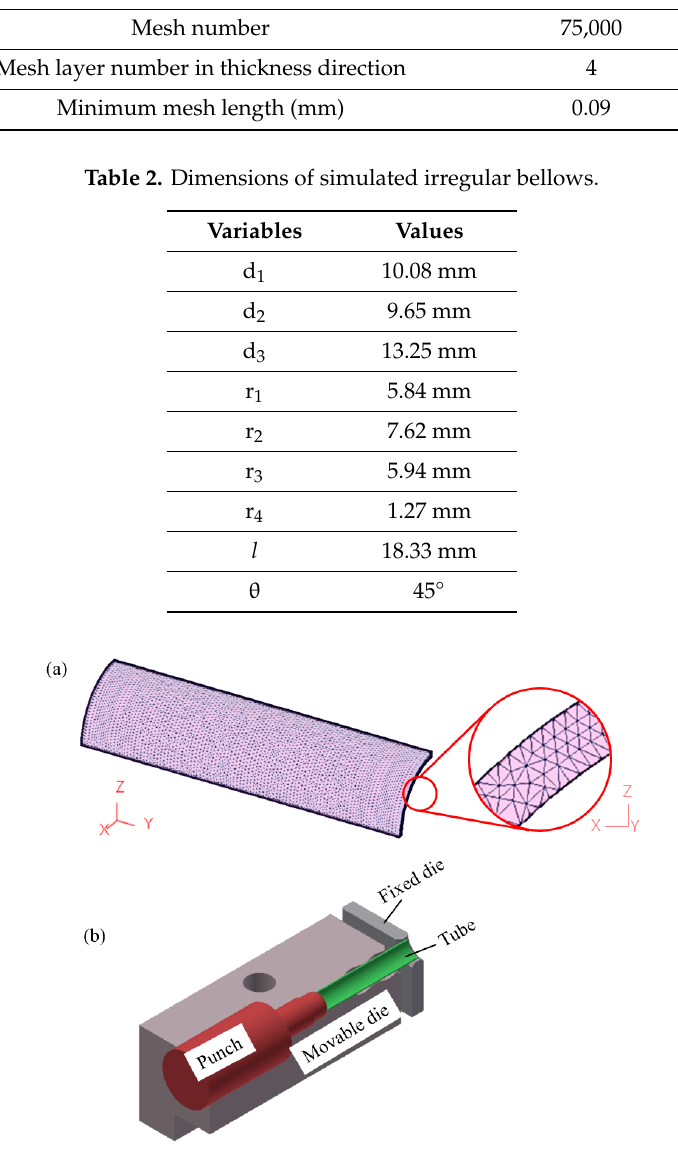
Table 1. Forming parameters used in FE simulations.